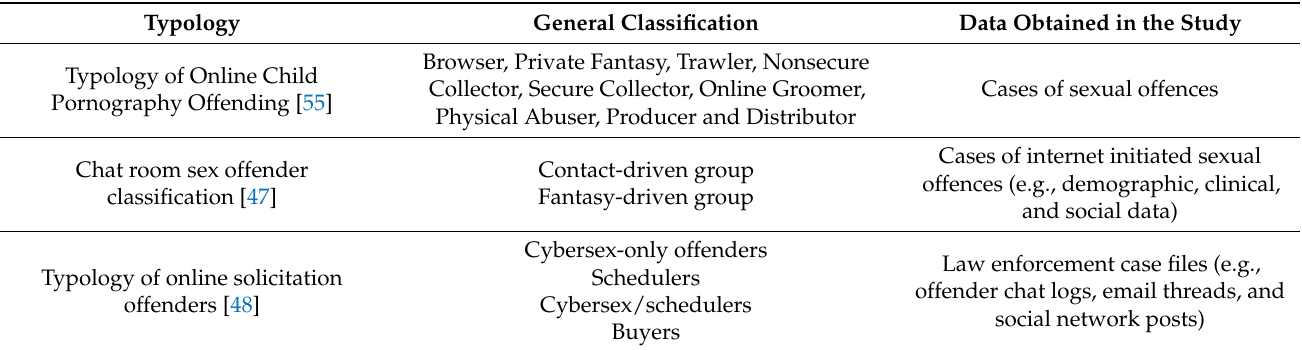
Table 2. Summary of OCSA typologies and source of data